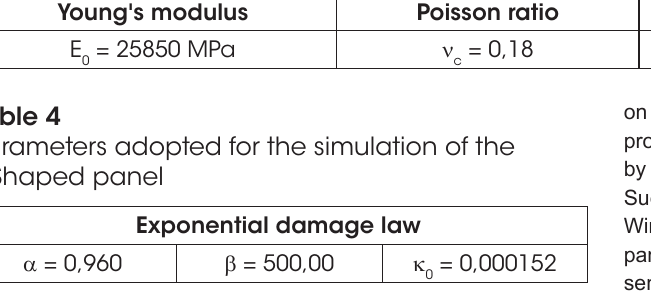
Figure 11 L-shaped panel: (a) geometry and boundary conditions; (b) mesh for GFEM with enrichment functions; (c) mesh for FEM with no enrichment